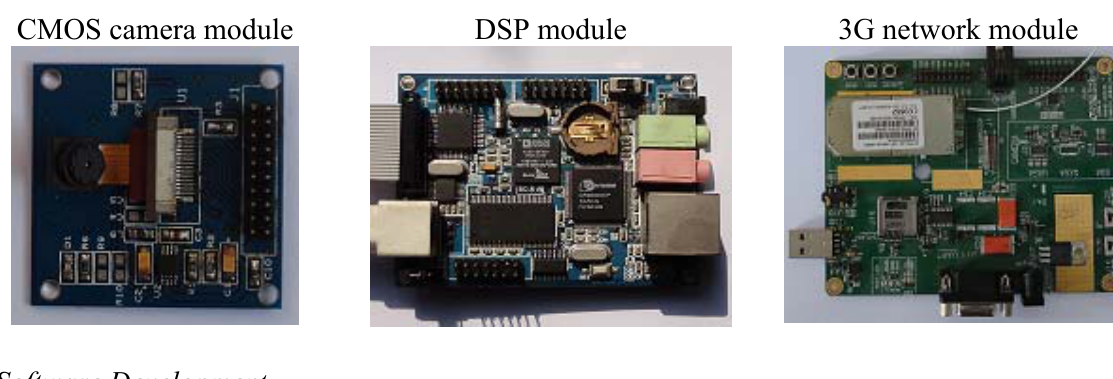
Figure 3. Photographs of the designed system including DSP module, CMOS camera module and 3G